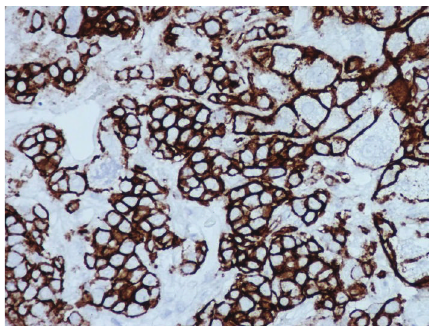
Figure 3: Positive Staining of intrasinusoidal plasma cells for CD138.